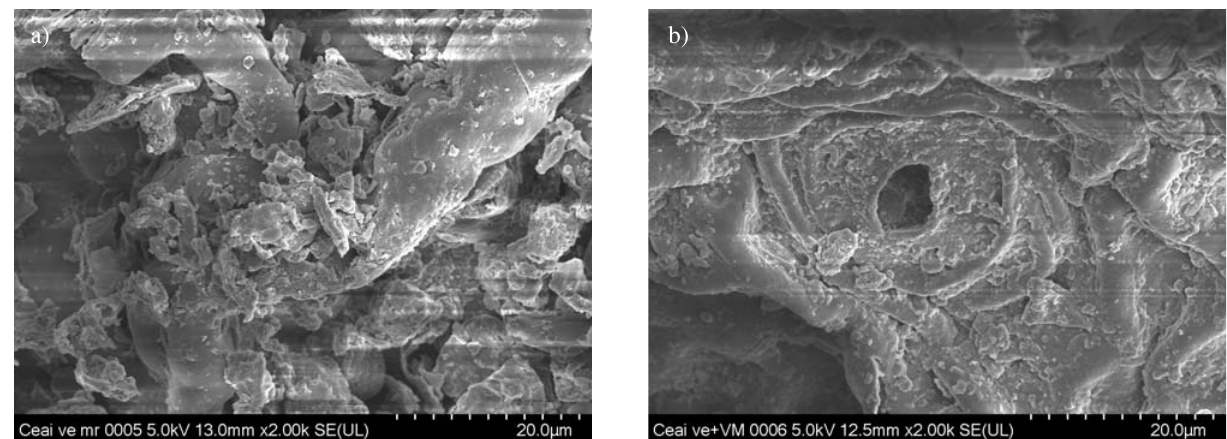
Figure 1. Scanning electron micrographs of untreated WGT before (a) and after (b) adsorptive removal of MG.